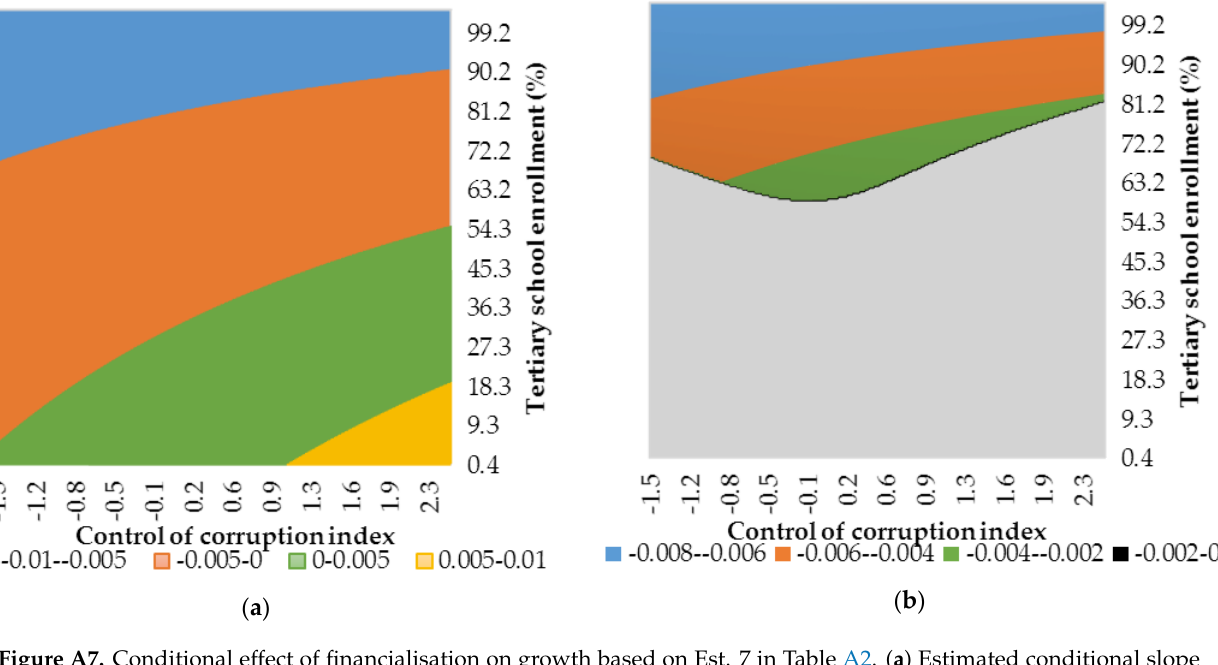
Figure A7. Conditional effect of financialisation on growth based on Est. 7 in Table A2. ( a ) Estimated conditional slope coefficient over the whole range of observed values for institutional quality and development level. ( b ) Estimated statistically significant conditional slope coefficient. Gray represents a combination of institutional quality and development level for which effect of financialisation on growth is statistically insignificant. Source: authors’ contributions.